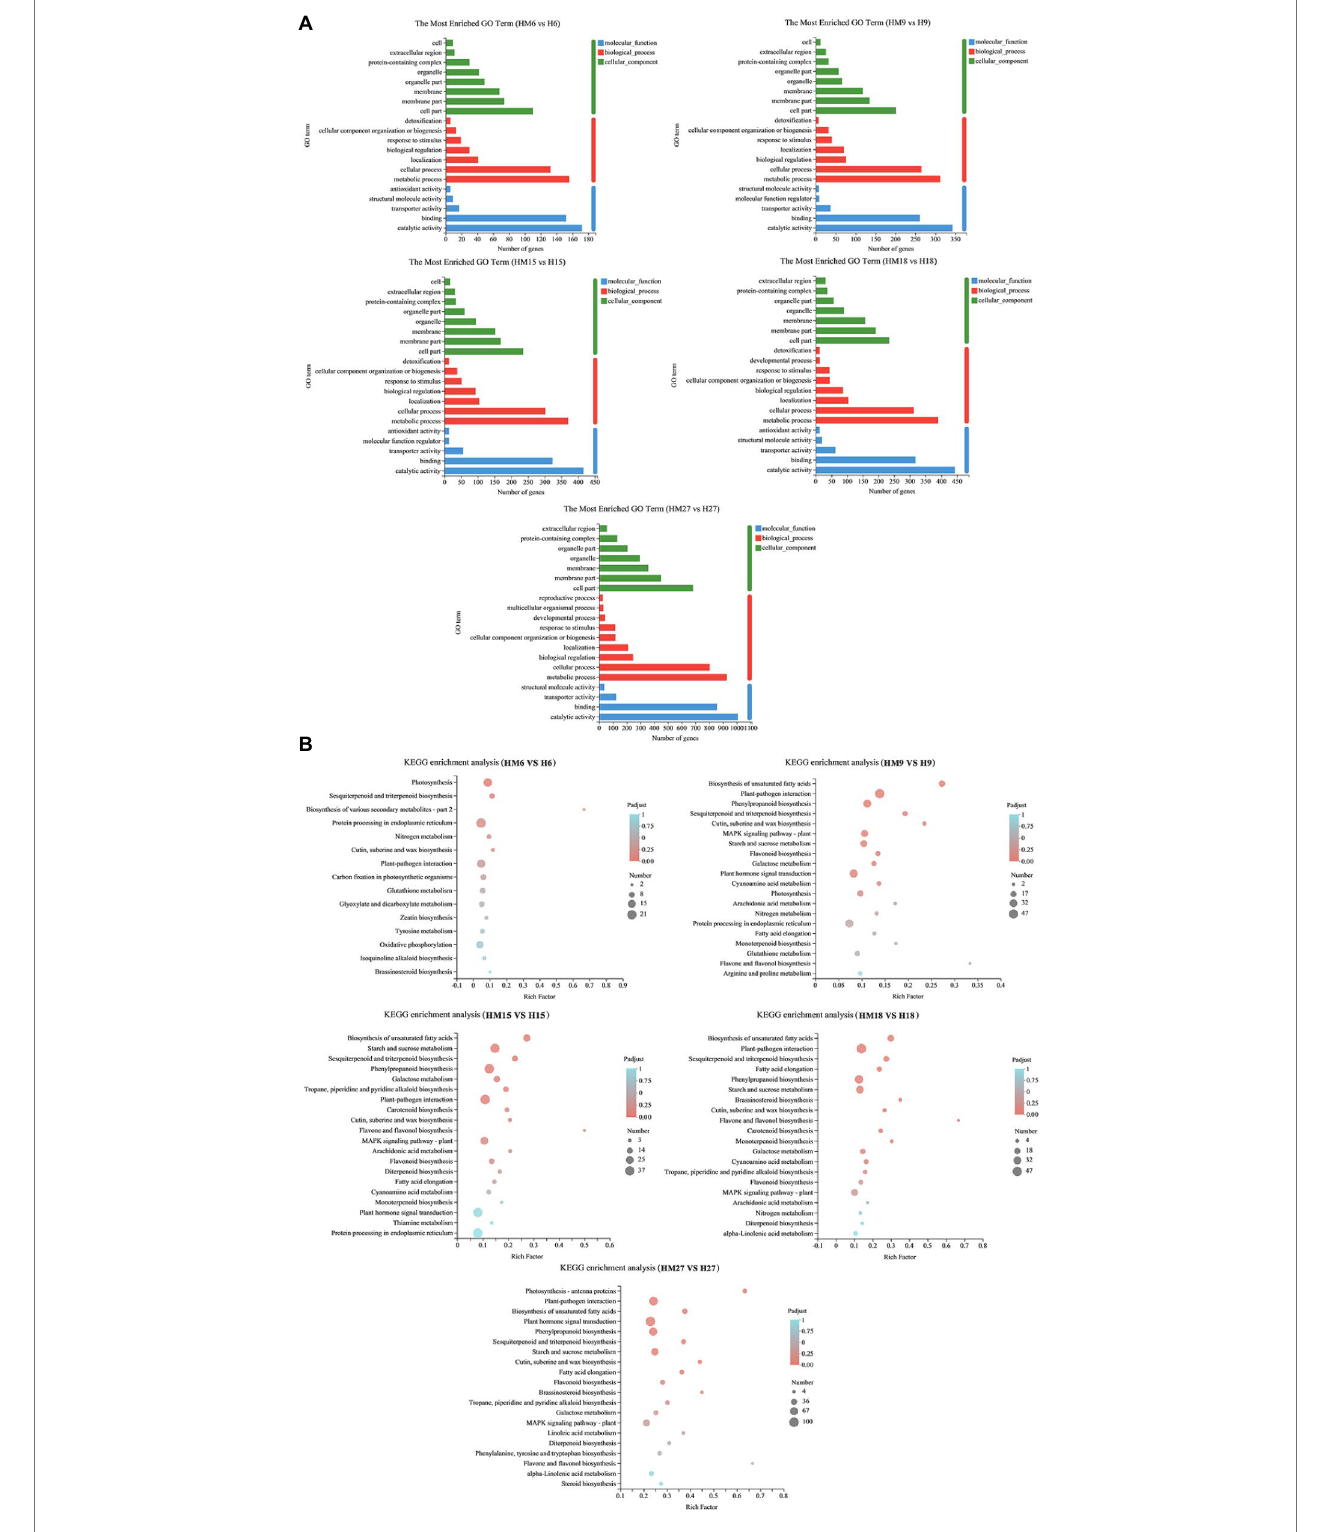
FIGURE 3 | GO classification and KEGG pathway enrichment of differentially expressed genes (DEGs) in lettuce leaves. (A) GO classification of DEGs. (B) KEGG pathway enrichment of DEGs. “MH” represents 100 μ mol L − 1 melatonin treatment under high temperature, and “H” represents no exogenous melatonin treatment under high